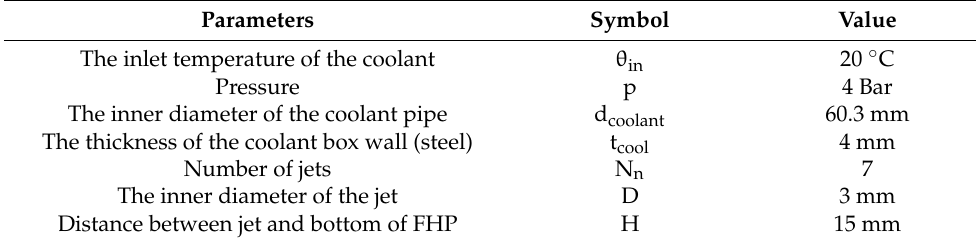
Figure 10. Coolant system used for mock-up: ( a ) illustration; ( b ) finalized nozzle heads. Table 4. Parameters of heat sink system with impinging jet.